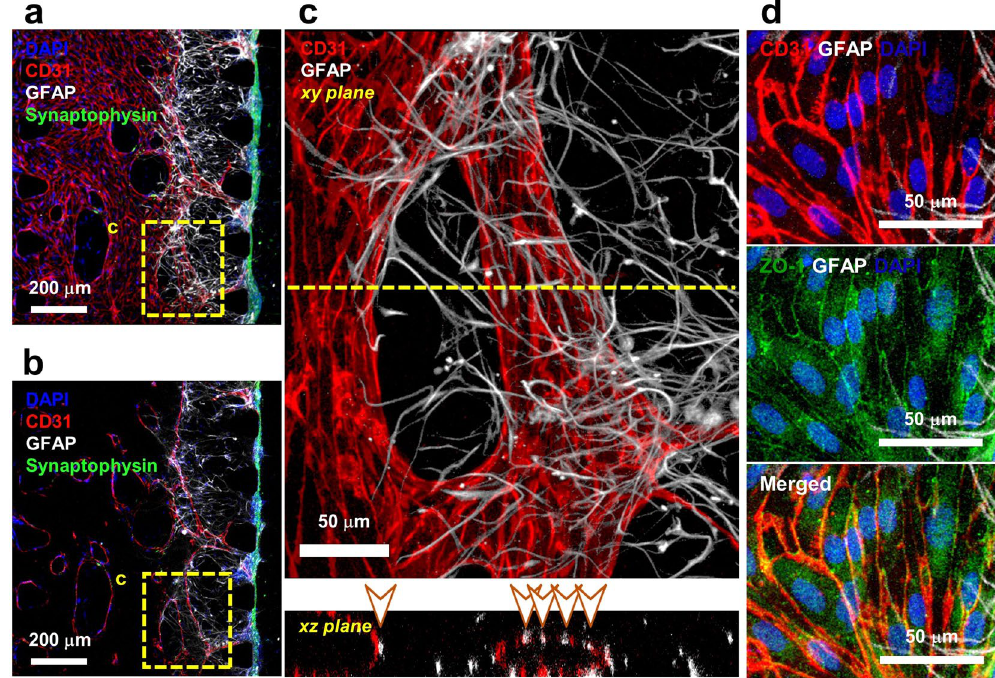
Figure 4. Immunostained imaging of the vascular network - astrocyte interface. ( a ) Astrocytic migration from the NC side neuron-astrocyte loading suspension follows the VEGF gradient towards the VC, and stops after directly interfacing with the vascular network. The neuronal synaptic network is clustered to the right of the fibrin gel, adjacent to the astrocyte-vascular interface. ( b ) An intermediate section layer of the NVU platform. Vascular network lumens form between each VC facing micropost, with each opening occupying the space of the entire post gap. The vascular network is perfusable from the VC, but is not connected to the NC. ( c ) Imaging of the direct vascular network-astrocyte interface. Confocal microscopy confirmed direct contact on two axes, with contact points indicated in the xz plane render via arrow points. ( d ) Vascular network - astrocyte contact confirmed through immunostaining for ZO-1 tight junction protein expression by CD31 positive endothelial